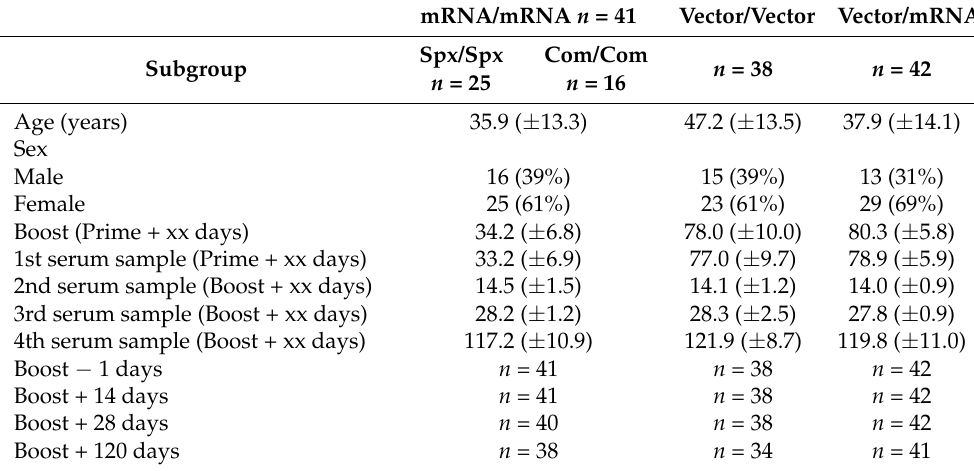
Table 1. Basic characteristics of the study groups. Spx—Spikevax, Com—Comirnaty. Subgroup